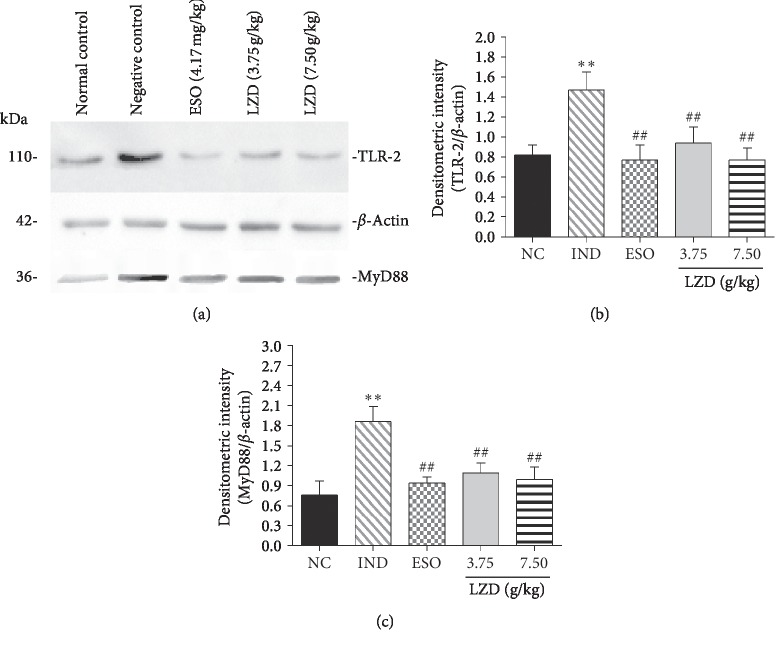
Effects of LZD on levels of TLR-2 and MyD88 protein expression during prevention of IND induced duodenal ulceration. (a) Representative immunoblots for TLR-2 and MyD88 proteins as measured by western blot analysis using specific antibodies. Loading control was monitored by β-actin immunoblotting. Quantitative analysis derived from densitometric scans of western blots of TLR-2 (b) and MyD88 (c) proteins of duodenal mucosa. Results are expressed as mean ± SEM, n = 3. Asterisks and pound signs indicate significant differences: ∗∗P < 0.01 versus normal control (NC); ##P < 0.01 versus negative control (IND).